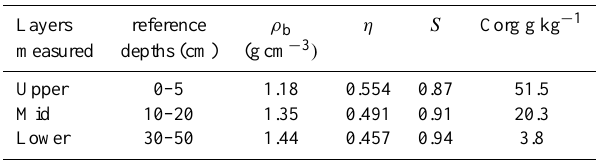
Table 1. Depths of sampled soil layers for computations of bulk densities, air filled porosity, the tortuosity factor (as used in Eqs. 1 and 2), the average soil organic matter content (in gCkg − 1 dry soil) at the different